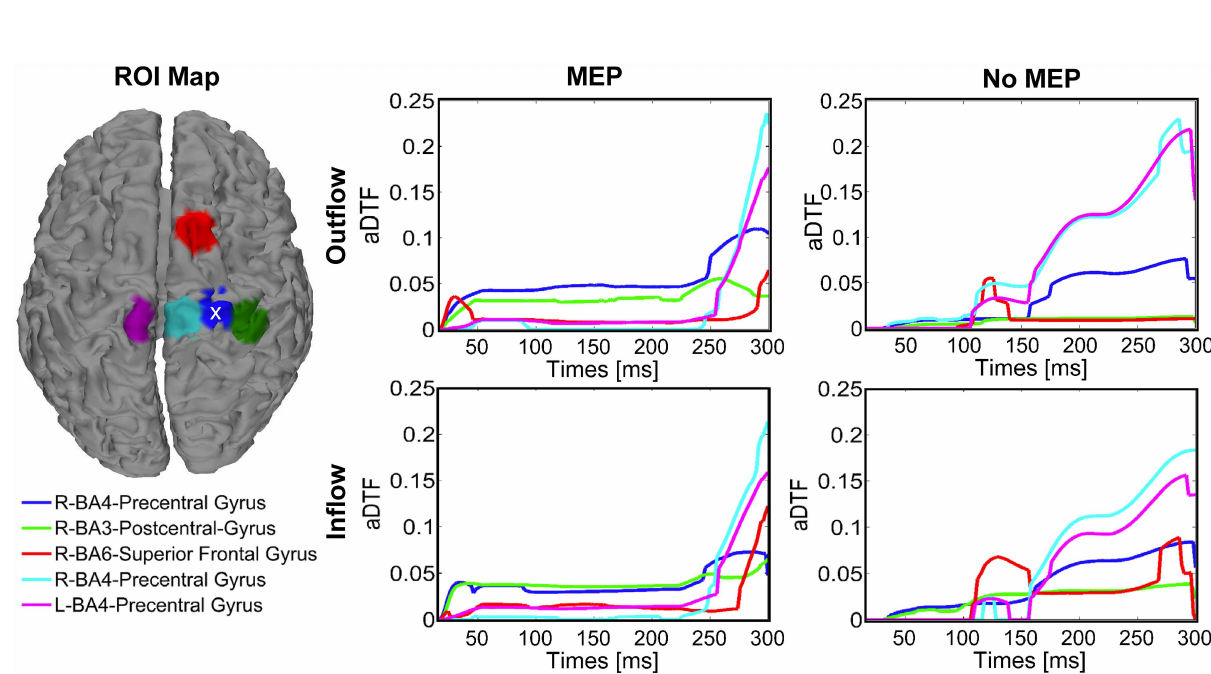
Fig 7. Inflow and outflow amongst ROIs for right M1 stimulation. Five ROIs were selected(left) using the cortical current density estimates for each latency (averageof 11 participants with simultaneous EMG recording). The ROI corresponding to the stimulationtarget is indicatedwith a white x. Time-varying connectivity, as measuredby aDTF, was calculatedfor each of the five ROIs for trials containing MEPs (middle column)and trials without MEPs (right column), including both outflow (top row) and inflow (bottom row) patterns.